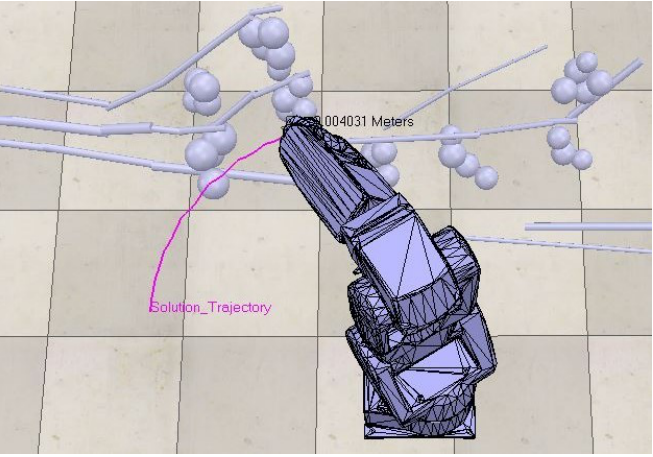
Figure 10. Robot final